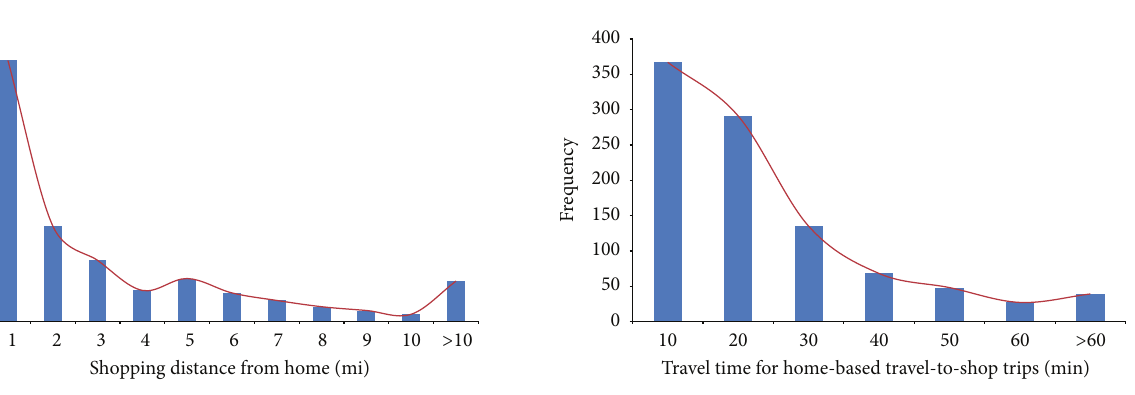
Figure 5: Distribution of shopping distance for the home-based travel-to-shop trips.